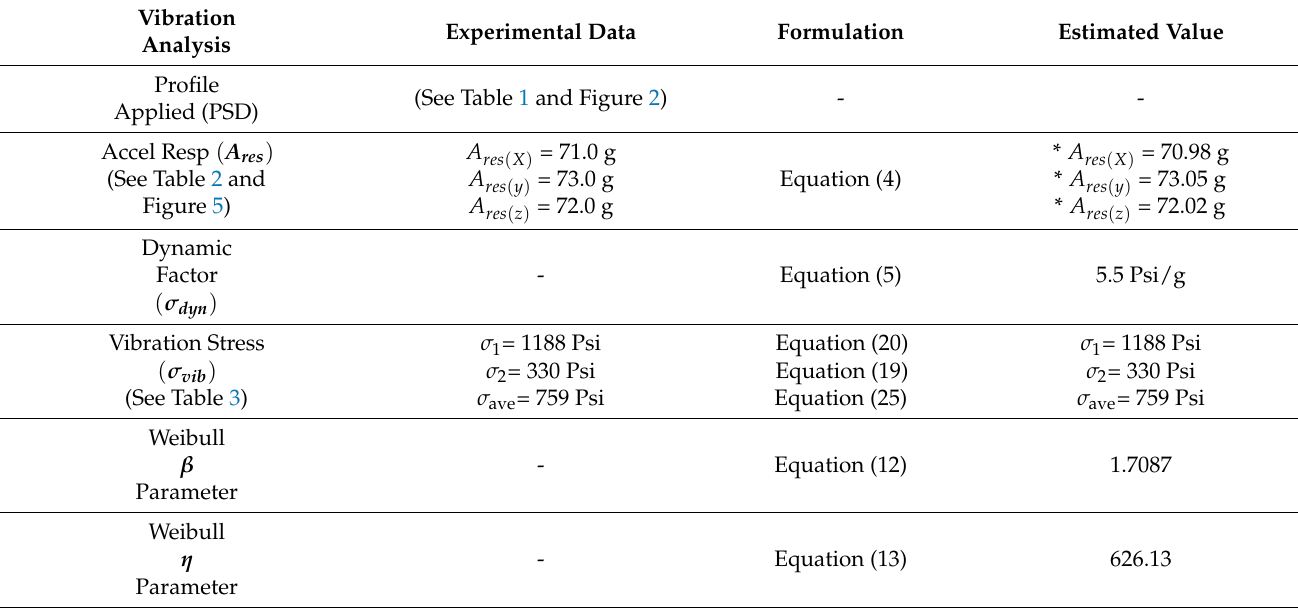
Table 6. Experimental and formulation comparison